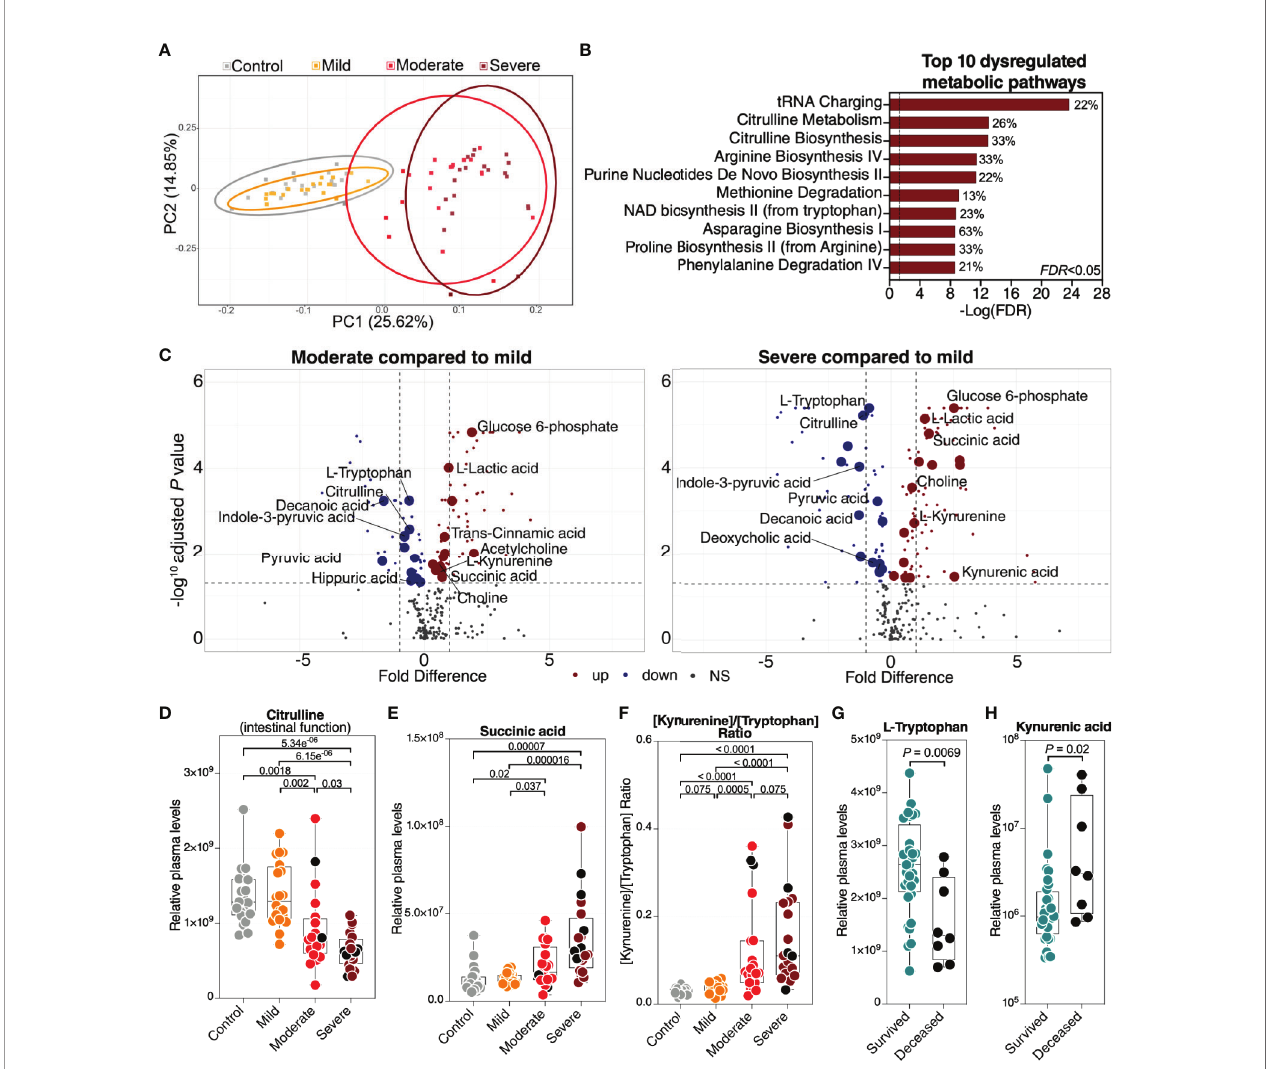
FIGURE 3 | Severe COVID-19 is associated with metabolic dysregulation. (A) Principal component analysis (PCA) of the 278 metabolites identi fi ed in the plasma of the study cohort. Each symbol represents a study participant. (B) Ingenuity Pathway Analysis (IPA) of the plasma metabolites modulated between the disease states with FDR<0.05. The graph shows the top 10 dysregulated metabolic pathways with FDR<0.05. Percentages beside each pathway represent the ratio of dysregulated metabolites among the total number of metabolites assigned to this particular pathway in IPA. (C) Volcano plots depicting plasma metabolites dysregulated in the moderate group compared to the mild group (left) or the severe group compared to the mild group (right). NS= non-signi fi cant. The gut- associated metabolites (from Table 1 ) are indicated by the larger symbols, and a selected set is identi fi ed by name. (D – F) As representative examples, levels of citrulline are lower (D) , levels of succinic acid are higher (E) , and the ratio between kynurenine/tryptophan [Kyn/Trp] is higher (F) during severe COVID-19 compared to mild COVID-19 or controls. Kruskal – Wallis test was used for statistical analysis. FDR was calculated using Benjamini-Hochberg method. (G, H) For key metabolites in the tryptophan catabolism pathway, levels of tryptophan are lower (G) , and levels of kynurenic acid are higher (H) in deceased COVID-19 hospitalized patients compared to survivors. Nominal P -value was calculated using the Mann – Whitney U test. Black dots indicate